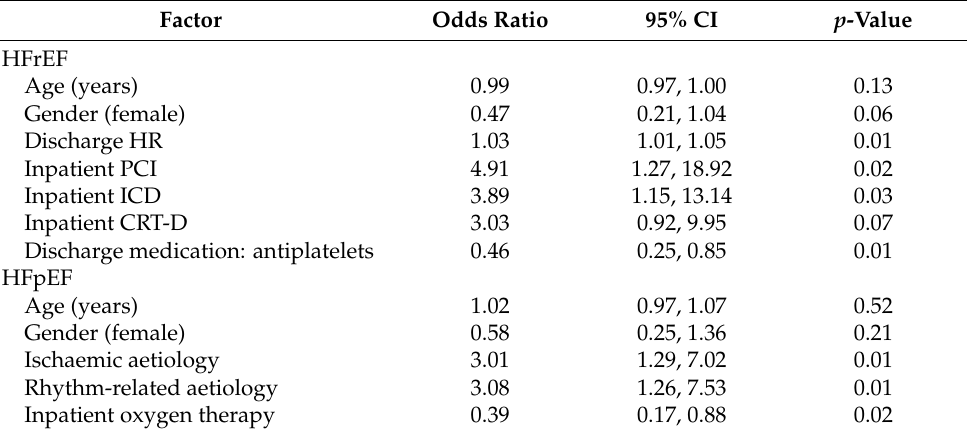
Table 3. Factors associated with referral to cardiac rehabilitation at time of discharge, in patients with HFrEF and